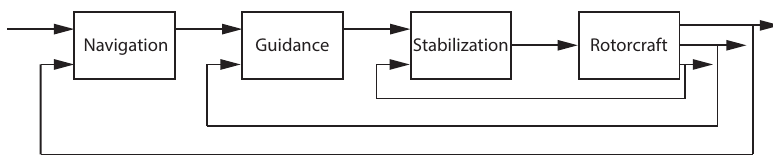
Figure 4. Multi-loop pilot model